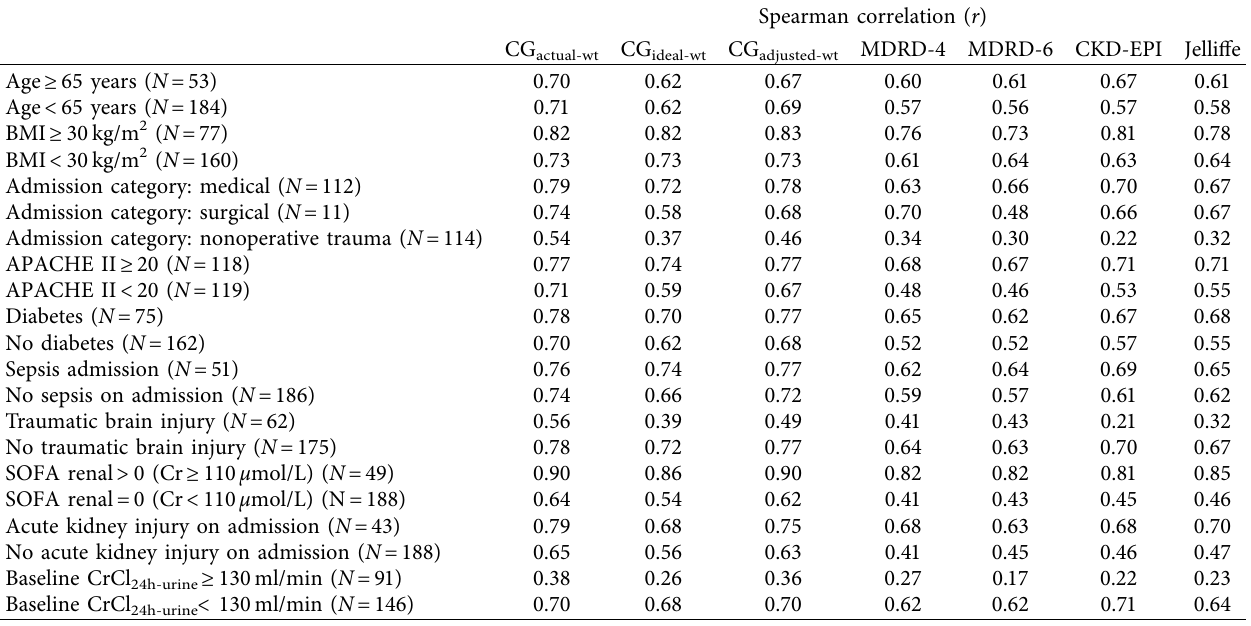
Table 4: Correlation between equations estimating glomerular filtration rate and creatinine clearance measured by 24-hour urine collection.